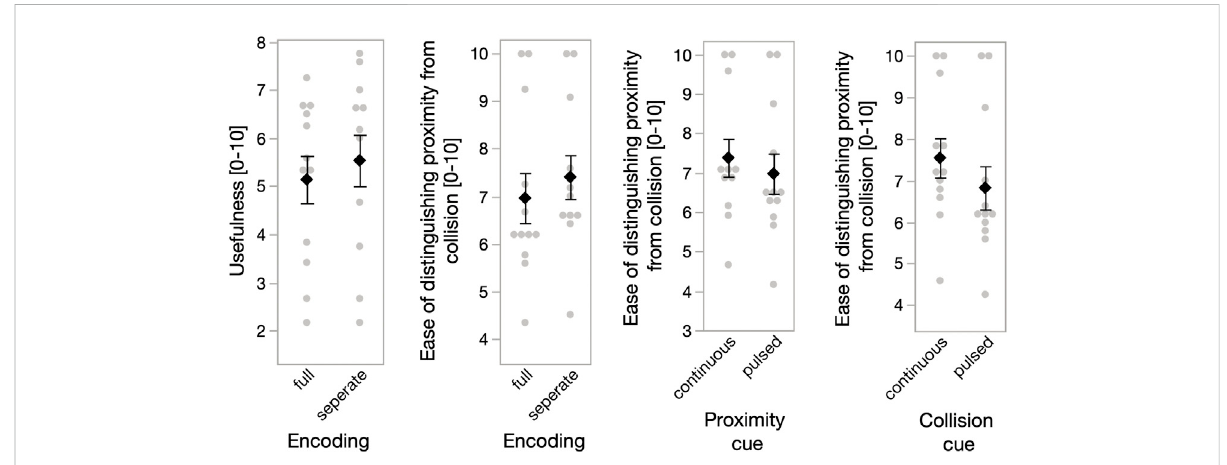
FIGURE 5 Illustration of signi fi cant main effects of encoding and vibration modes on usefulness and distinguishability ratings in Study 3, plotted as in Figure